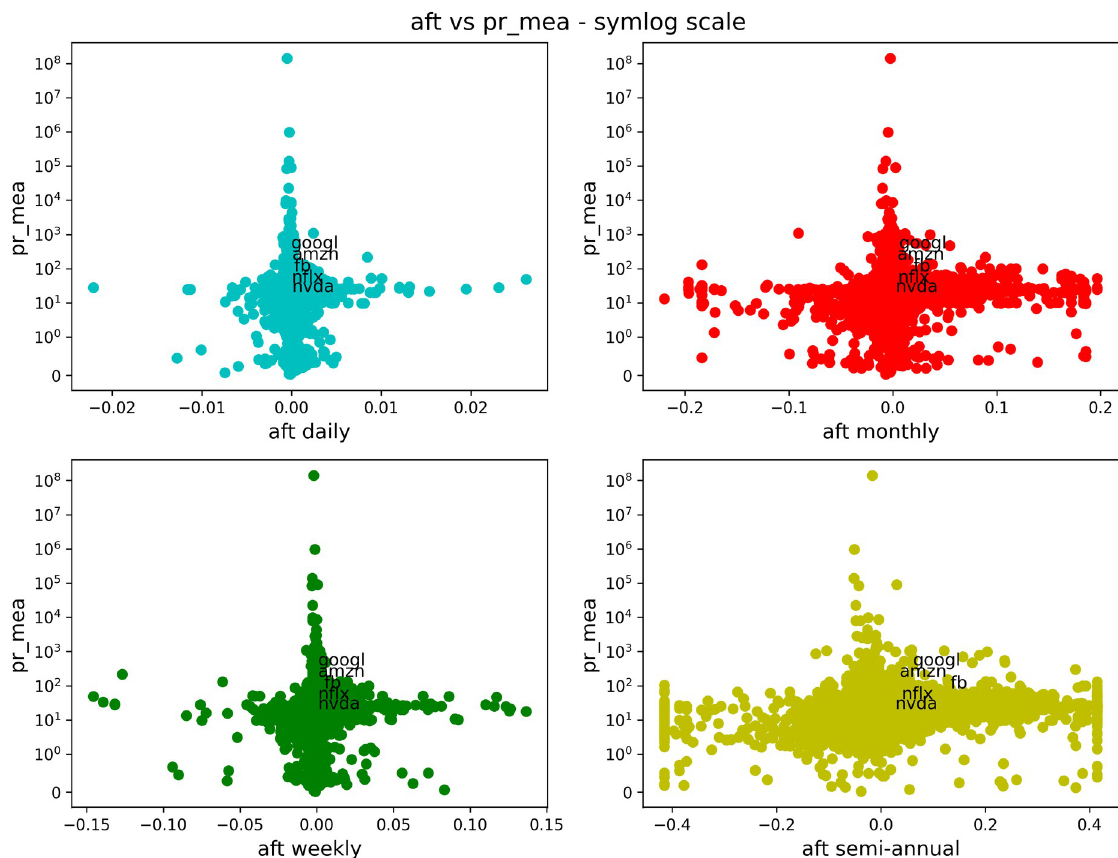
Fig 5. Comparison of antifragility values and pr_mea in stocks. Each subplot corresponds to a timescale (daily in cyan, weekly in green, monthly in red, semiannual in yellow). The plots compare the antifragility A measure (in the x -axis) to the pr_mea of each asset. We observe how higher values of the ‘good-performance’ measure concentrate in the robust axis A = 0